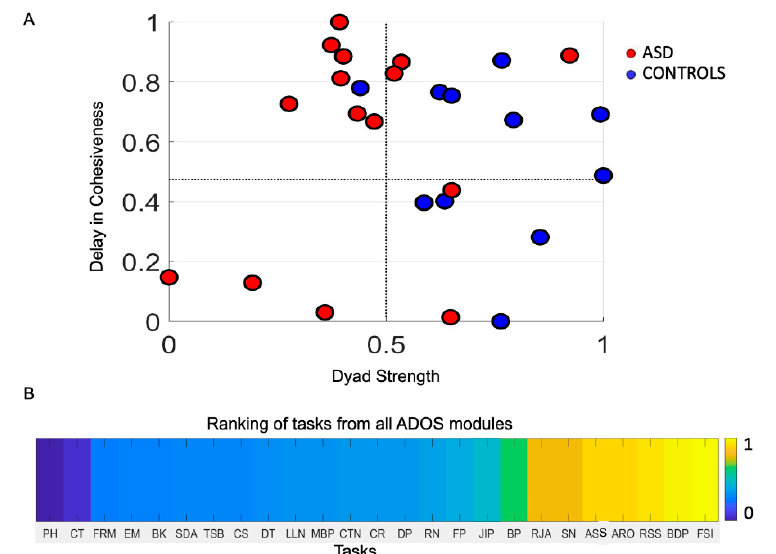
Figure 8. Digital biomarker for personalized design of adaptive targeted therapy. ( A ) Parameter space spanned by dyad strength on x-axis and delay in cohesiveness (see text for details) on the y-axis. Ideally within a social interaction one would desire high dyad strength and a broad range of response cohesiveness, spanning from fast to slow. Note that most controls have high dyad strength and their responses vary broadly from lower to higher cohesiveness delay, whereas autistics are primarily in the region of low dyad strength and delayed cohesiveness (i.e., they synchronize their body biorhythms with those of the rater, but there is a larger lag than desirable.) ( B ) Task ranking criteria based on dyad strength calculated for various tasks from participants in visit one. Functional and Symbolic Imitation, FSI is assigned the highest rank (easiest task to perform) as it depicts the best dyad strength while PH having the lowest dyad strength is assigned the lowest rank (most di ffi cult task to